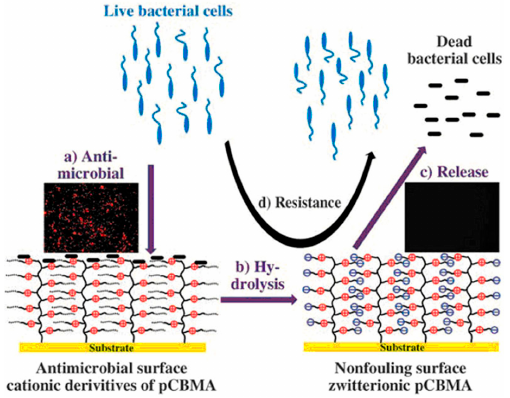
Figure 1. A schematic application of poly(7) as a switch where ( a ) a surface with polycationic state poly(7) possessing antibacterial properties that, ( b ) through alkaline hydrolysis, ( c ) the surface switches to polyzwitterionic state poly(8) and dead bacteria cells are released from surface and, finally, ( d ) the poly(8) surface becomes resistant to bacterial adhesion. Reprinted with permission from Reference [48], Copyright 2008, Wiley-VCH.